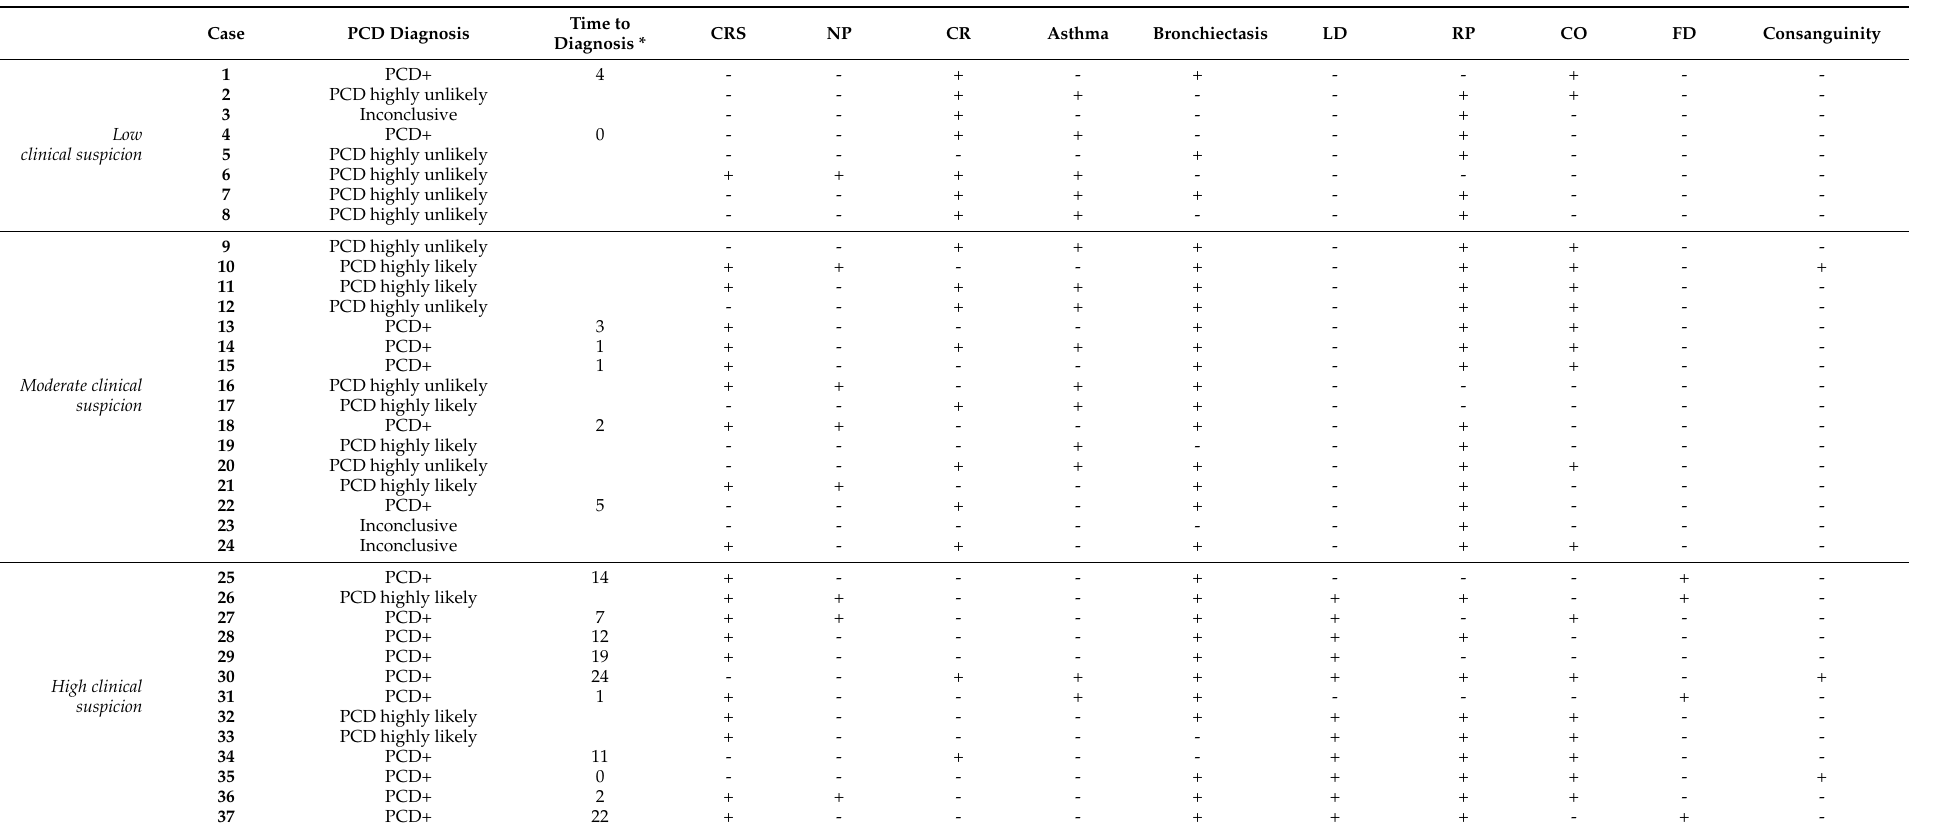
Table 1. Clinical characteristics and time to diagnosis in individuals with low, moderate, and high suspicion for primary ciliary dyskinesia